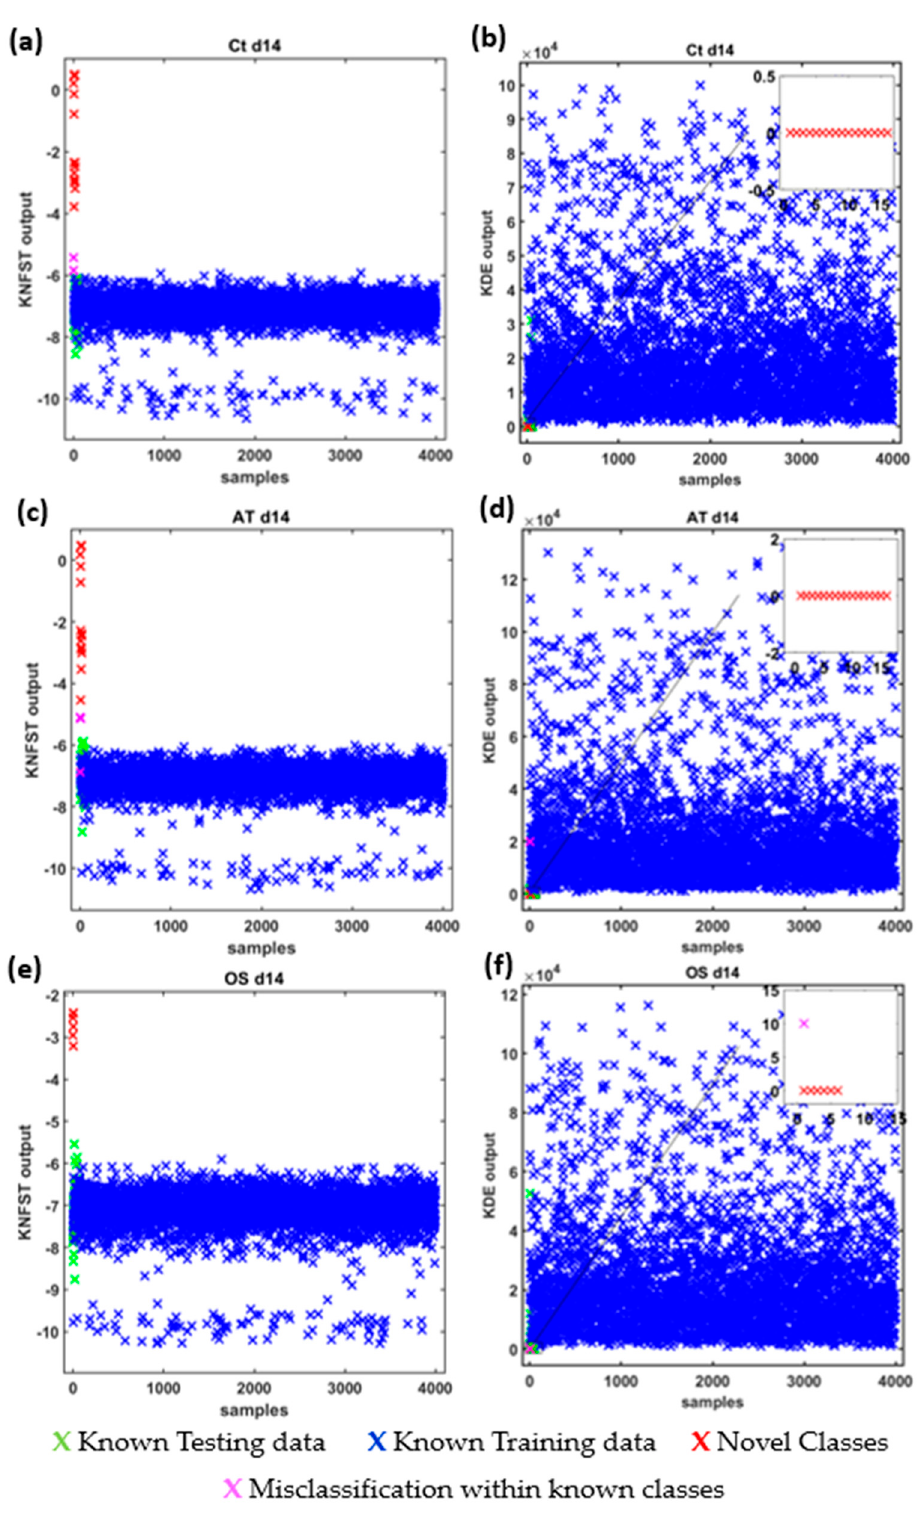
Figure 5. Novelty scores and threshold values of KDE and KNFST classifiers for Ct d14 ( a , b ), AT d14 ( c , d ) and OS d14 ( e , f ). Ct d14: Figure 6 shows the confusion matrices for the output of the classifier KNFST and KDE for the Ct d14 sample. Both classifiers were able to detect all the sixteen novel frequencies which belong the fatty acids, 1-methylnicotinamide, myo-